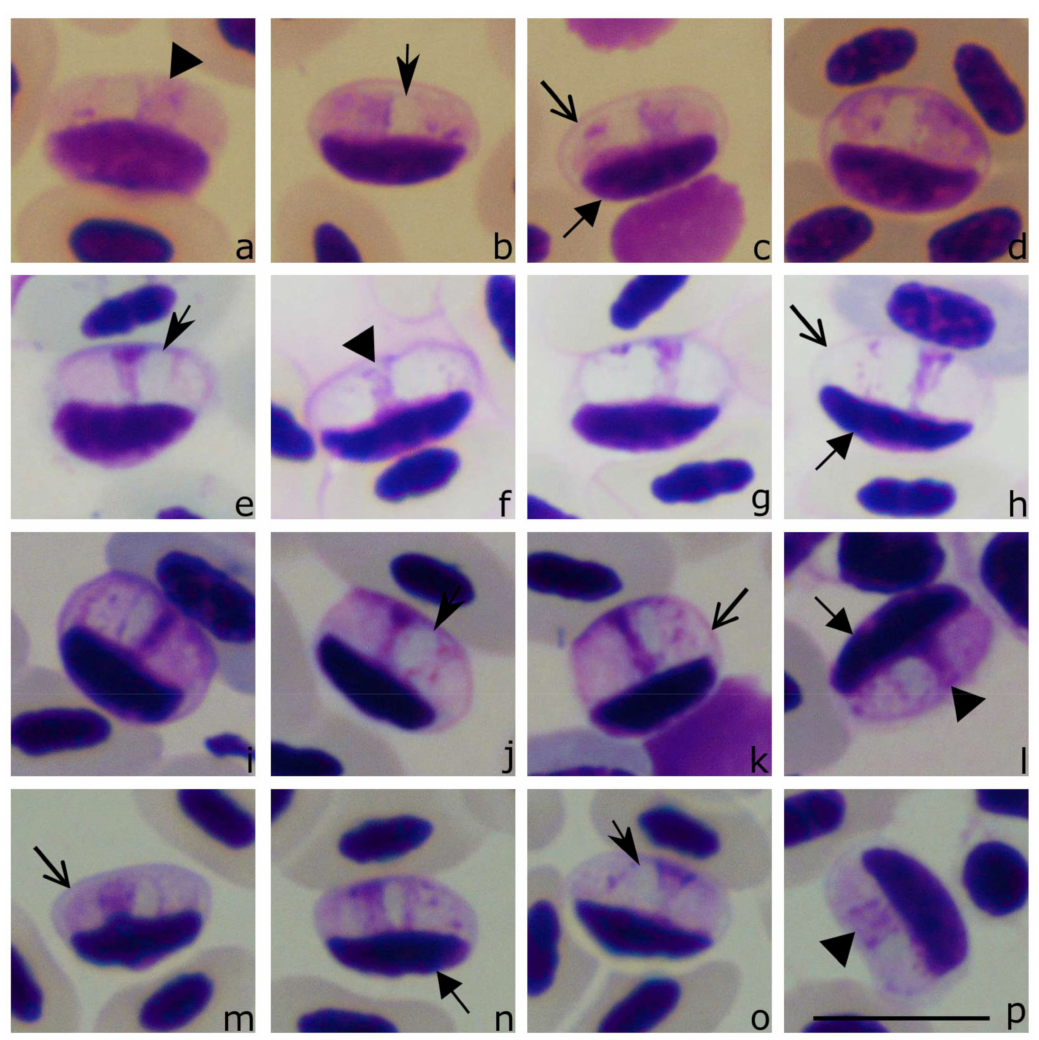
Figure 2. Sporozoites ( a – p ) of Lankesterella sp. 18S rRNA lineages: LanAcro4 from the Eurasian reed warblers Acrocephalus scirpaceus ( a – d ) (see clade D in Figure 1), LanHipp1 from the icterine warbler Hippolais icterina ( e – h ) (clade D in Figure 1), LanAcro9 from the great reed warbler Acrocephalus arundinaceus ( i – l ) (clade E, Figure 1), and LanAcro5 from the Eurasian reed warblers Acrocephalus scirpaceus ( m – o ) (clade F, Figure 1). Note that all sporozoites develop in thrombocytes, whose relatively thick cell envelope is readily visible ( c , h , k , m ). The parasite nucleus is elongate and occupies entire parasite width ( a , f , l , p ); markedly condensed chromatin is sometimes visible ( l ). A vacuole-like structure is closely appressed to the parasite nucleus ( b , e , j , o ). Triangle, parasite nucleus. Barbed arrowhead, vacuole-like structure. Short triangle arrow, host cell nucleus. Simple wide arrowheads, thrombocyte envelope. Scale bar: 10 µ m. Methanol fixed and Giemsa-stained blood